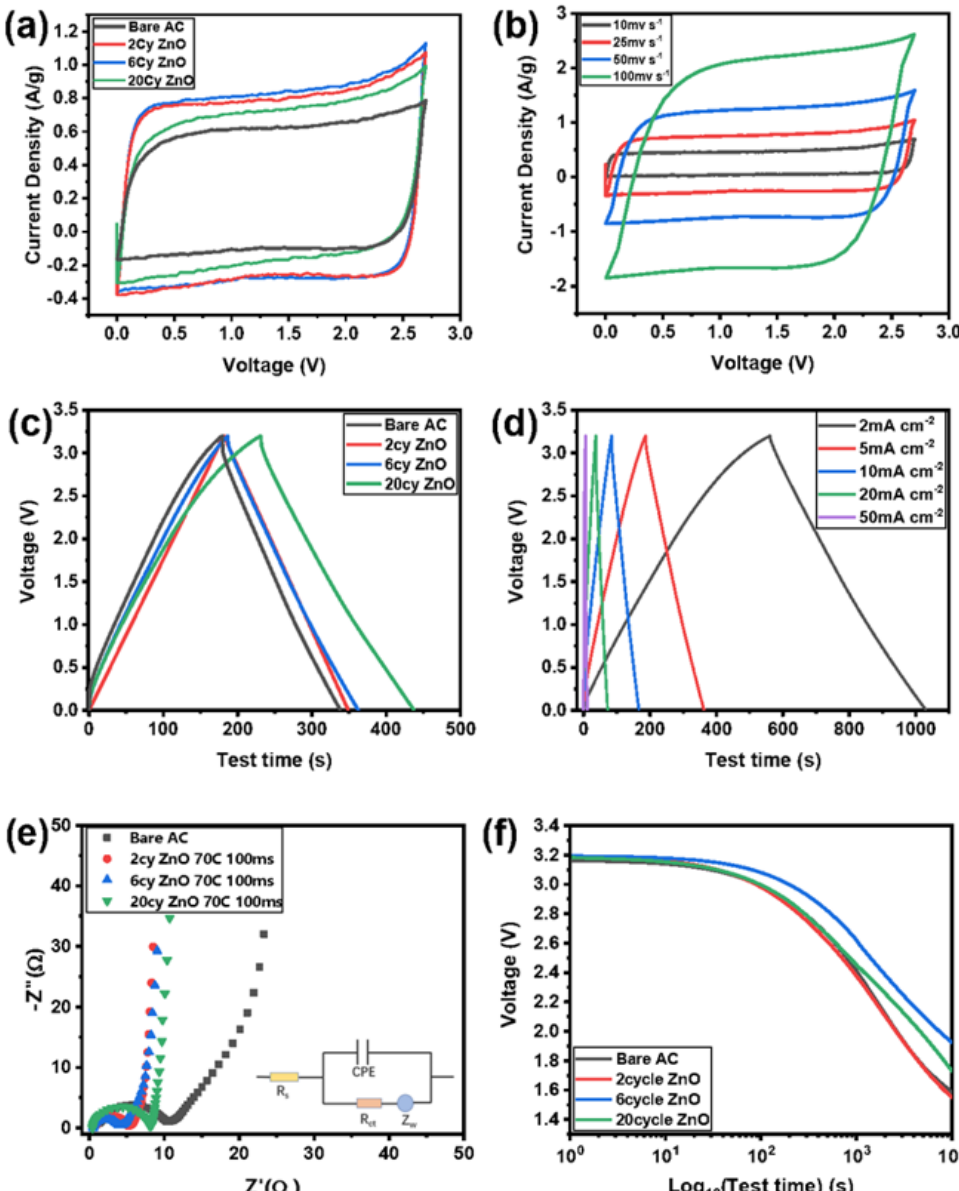
Figure 7. Electrochemical characterization of ZnO-coated AC at 100 ms and 70 ◦ C: ( a ) at different ALD coating cycles at the scan rate of 25 mV/s; ( b ) CV loop of 6-cycle ZnO coating at different scan rates; ( c ) GCD curves at different ALD coating cycles; ( d ) Charge-discharge profiles of 6-cycle ZnO coating at 3.2 V using different current densities; ( e ) EIS spectrum of various ZnO ALD coated AC; (f) Self-discharge behavior of various ZnO ALD coated AC.